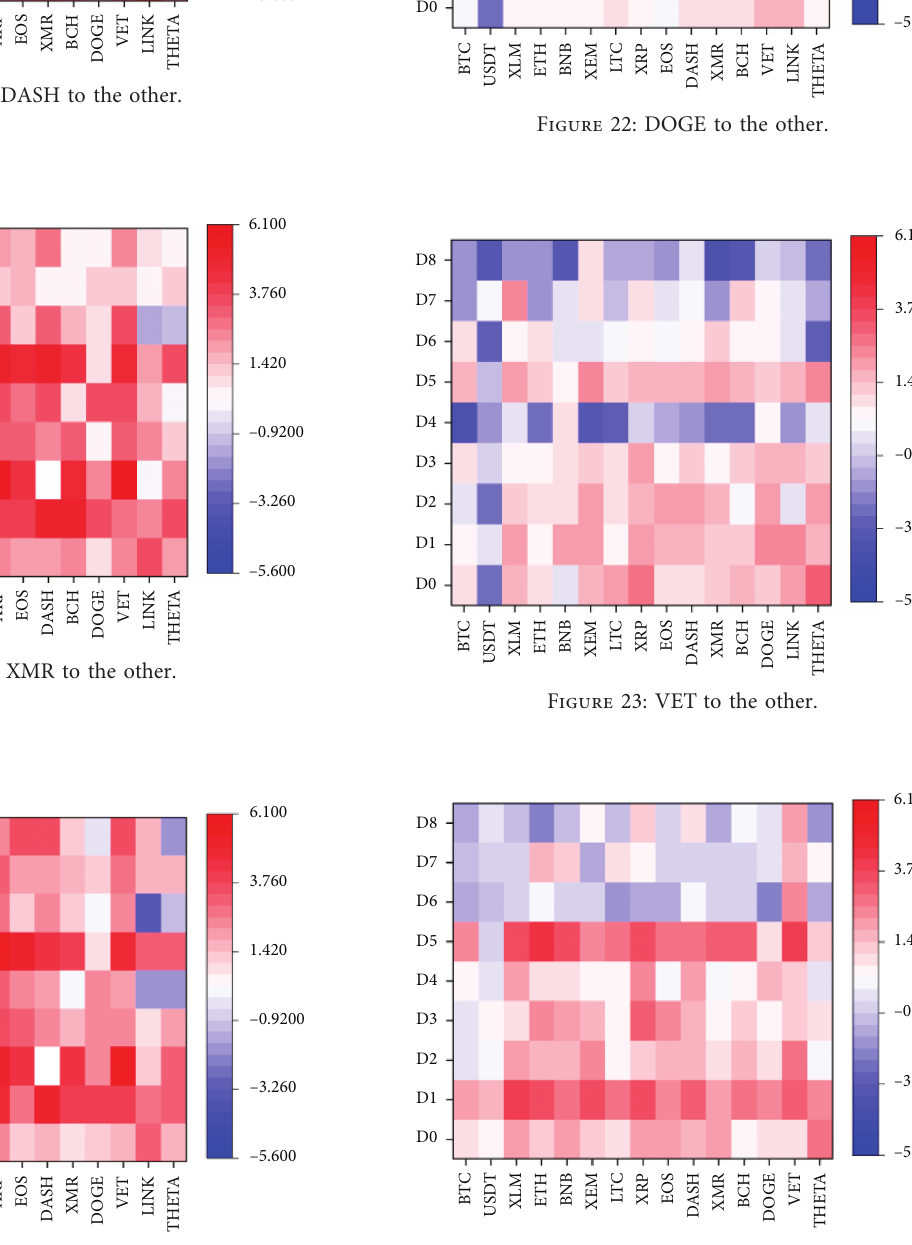
Figure 21: BCH to the other.